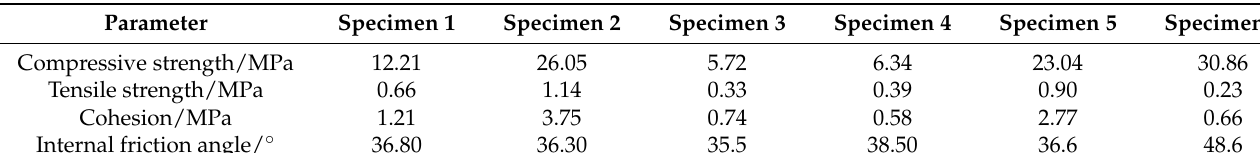
Table 2. Basic mechanical parameters of coarse-grained sandstone.